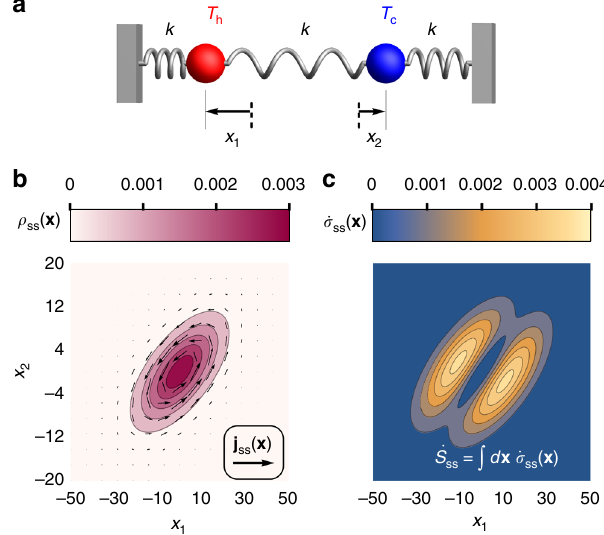
Fig. 1 Two coupled beads at different temperatures. a An illustration of the model with the red bead immersed in a hot temperature bath T h and the blue bead immersed in a cold temperature bath T c . Three springs with equal spring constant k connected the beads and the walls. Displacements away from the equilibrium position of the hot and cold beads are denoted by x 1 and x 2 , respectively. b The steady-state probability density and current as a function of bead displacements for spring constant k = 1, friction γ = 1, and thermal energy scales k B T c = 25 and k B T h = 250. c The local entropy production rate calculated from Eq. (7) of the system as a function of bead displacements for the same